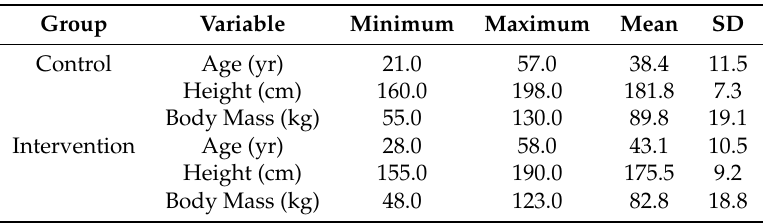
Table 2. Baseline data for the control and intervention groups.